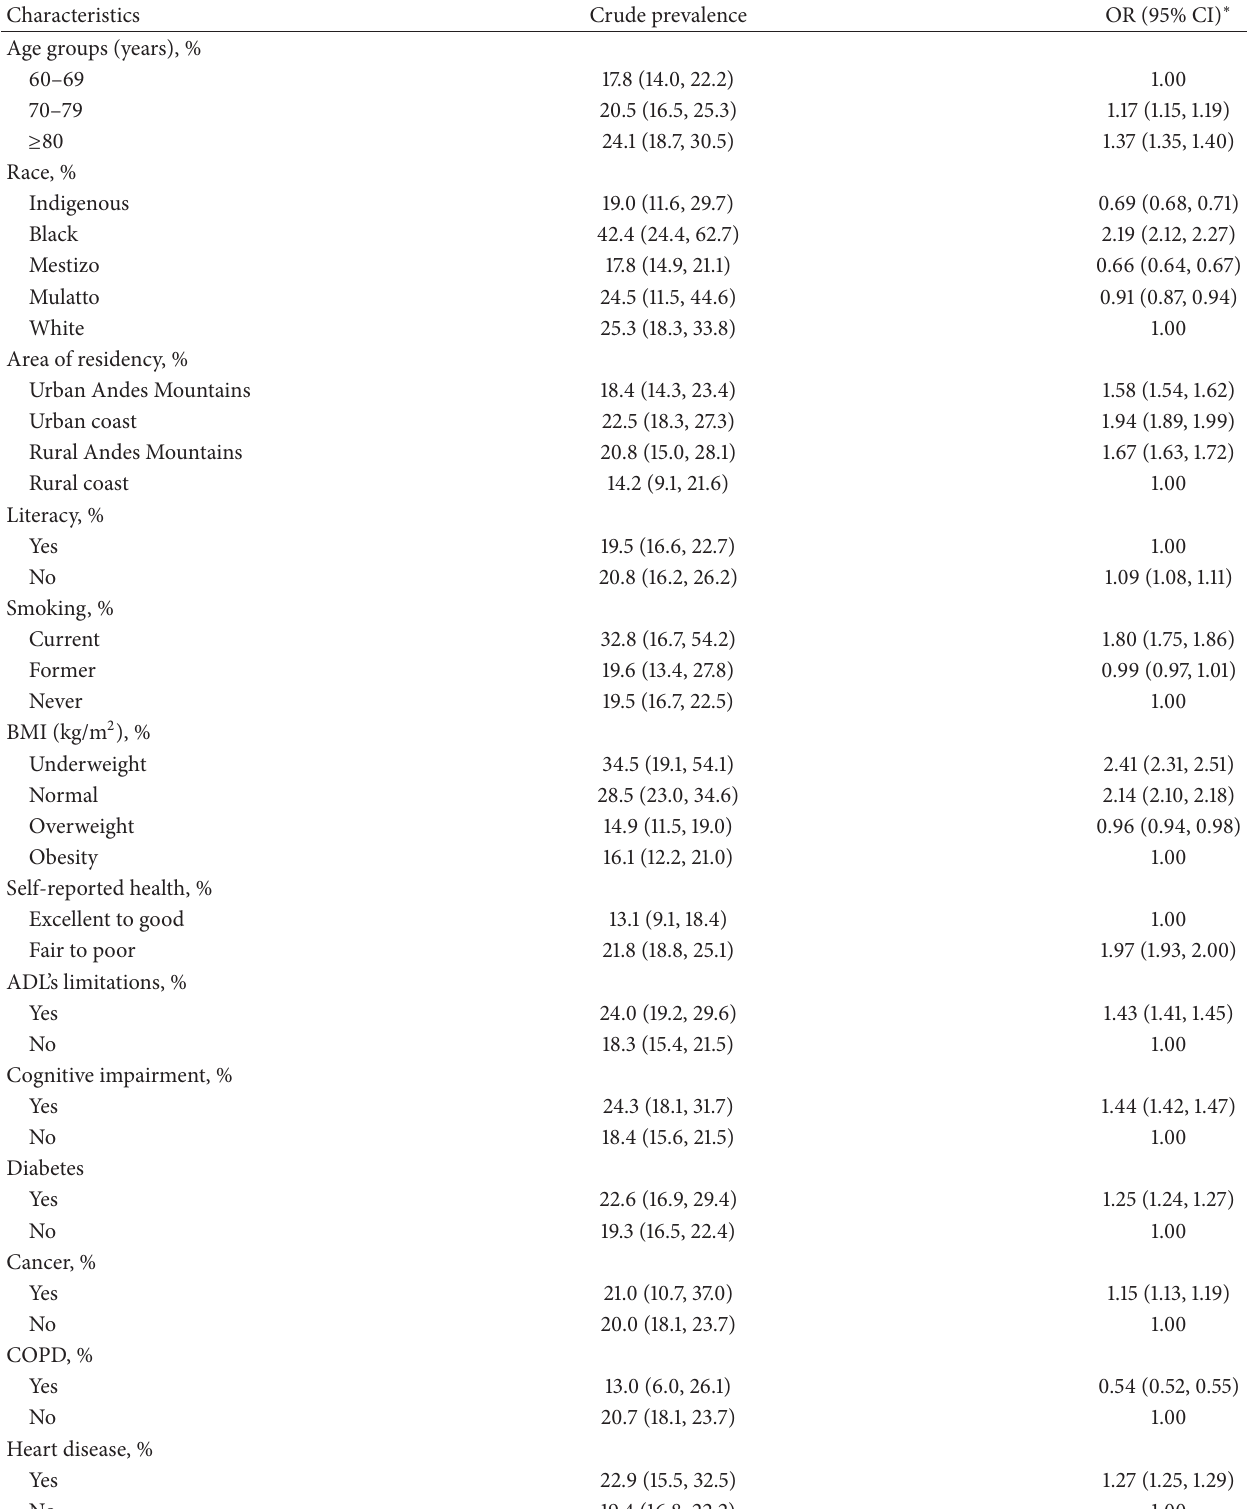
Table 2: Prevalence of anemia among older women in